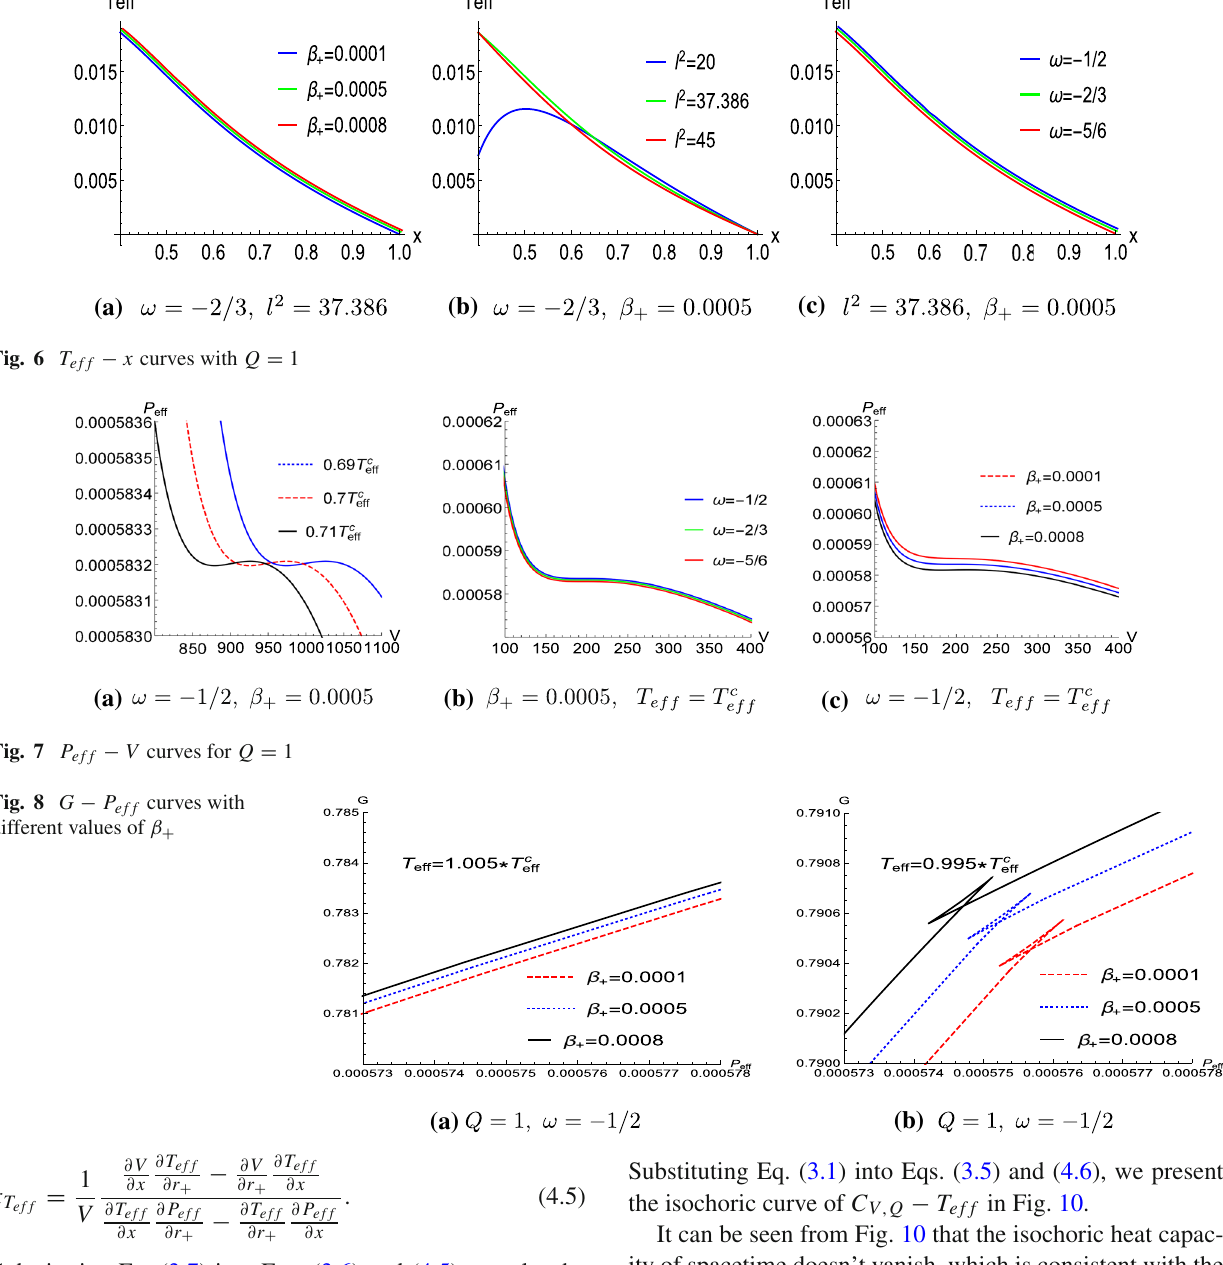
Fig. 6 T ef f − x curves with Q = 1